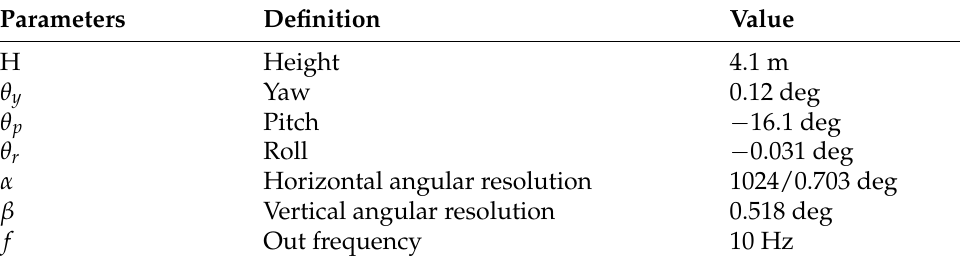
Table 1. Configuration parameters for the